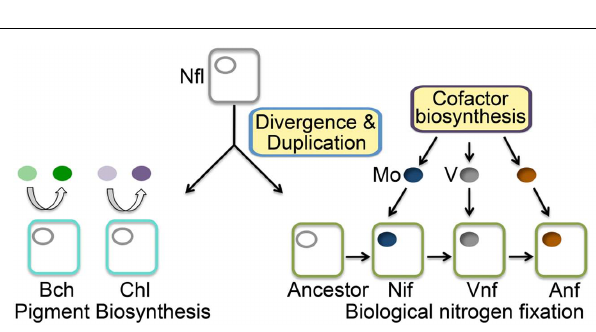
FIGURE 3 | Model depicting the divergence of nitrogenase (NifD) and protochlorophyllide reductase (ChlN/BchN) from a NflD ancestor.